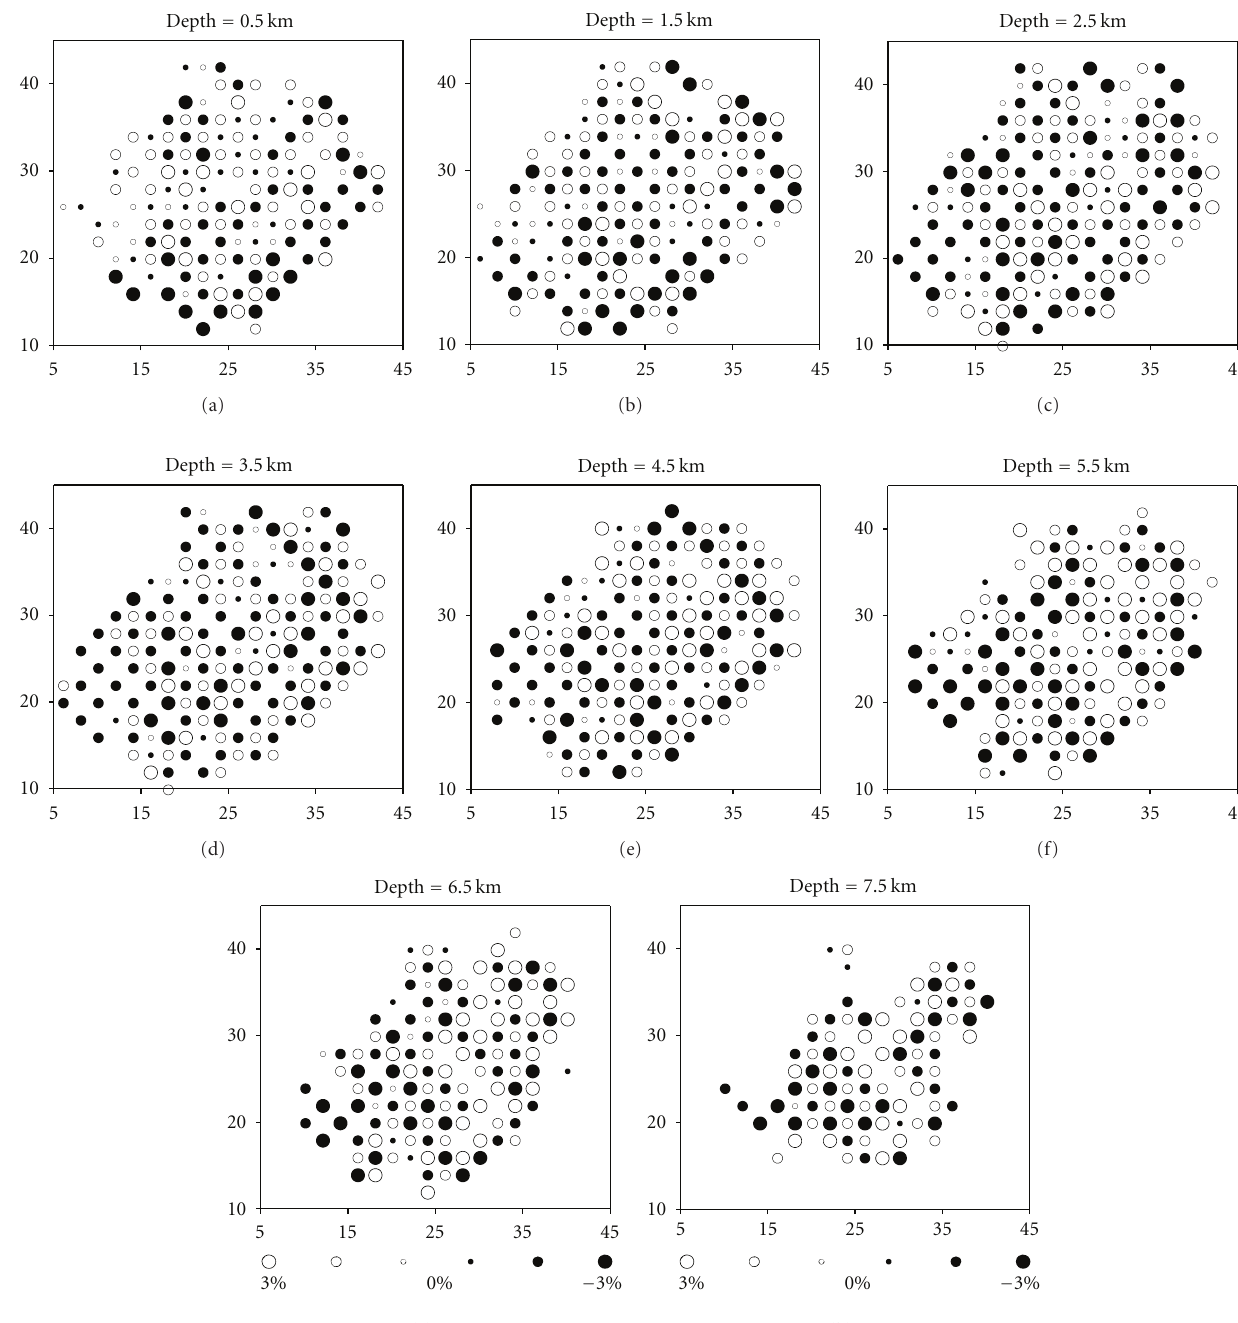
Figure 4: Results of checkerboard resolution test. Open and closed circles denote slow and fast velocities, respectively. The depth of each layer is shown at the upper part of the map. The grid spacing is 2km in the horizontal direction and 1km in depth. The perturbation scale is shown on the right. The coordinates are in